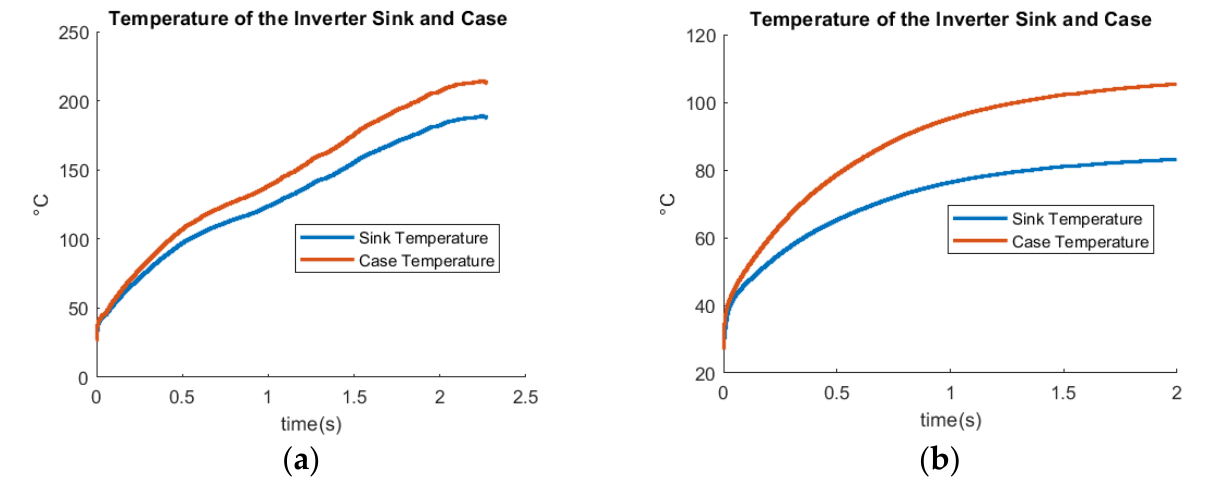
Figure 25. Sink and case temperatures for ( a ) the inverter module of the BqZSI topology and ( b ) the inverter module of the 3-level DC/DC converter.